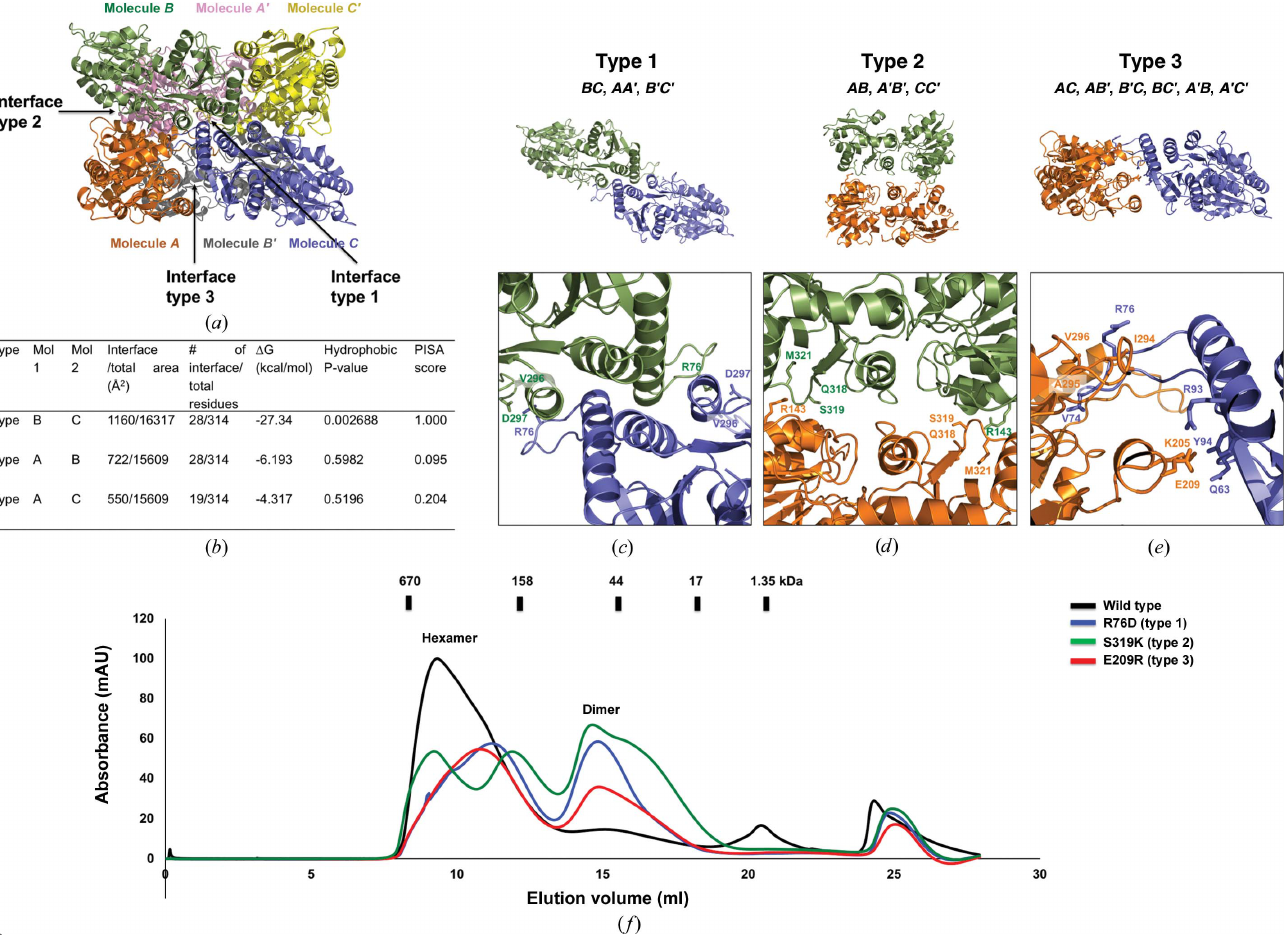
Figure 3 Details of the interface formed by the hexameric homo-oligomeric complex of abMurG. ( a ) Cartoon representation of the hexameric abMurG complex. Three different types of interfaces (types 1–3) formed by the hexameric complex are indicated by black arrows. ( b ) Table summarizing the interaction details of each type of interface. ( c , d , e ) Cartoon representation of each type of interaction interface: type 1 ( c ), type 2 ( d ) and type 3 ( e ). The position of each interface and the molecules involved in the formation of each interface are shown in the upper panel. Close-up views of each interface showing the residues involved in the formation of the interface are provided in the lower panels. ( f ) Verification of the interfaces by mutagenesis. Size-exclusion chromatography profiles comparing the positions of eluted peaks between wild-type abMurG and various mutants with disrupted type 1 (R76D), type 2 (S319K) and type 3 (E209R)